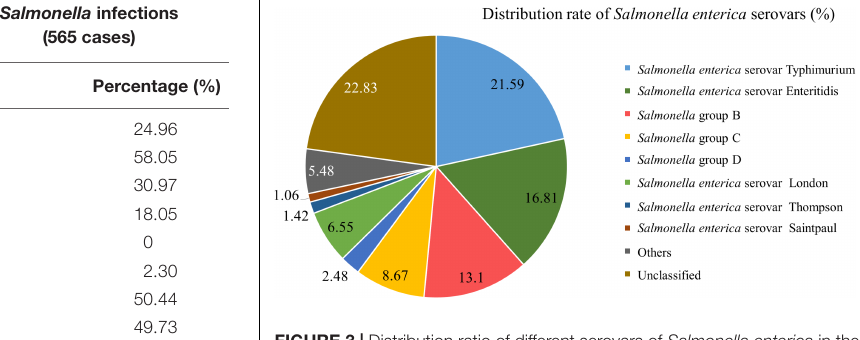
FIGURE 3 | Distribution ratio of different serovars of Salmonella enterica in the Southwest of Shanghai from 1998 to